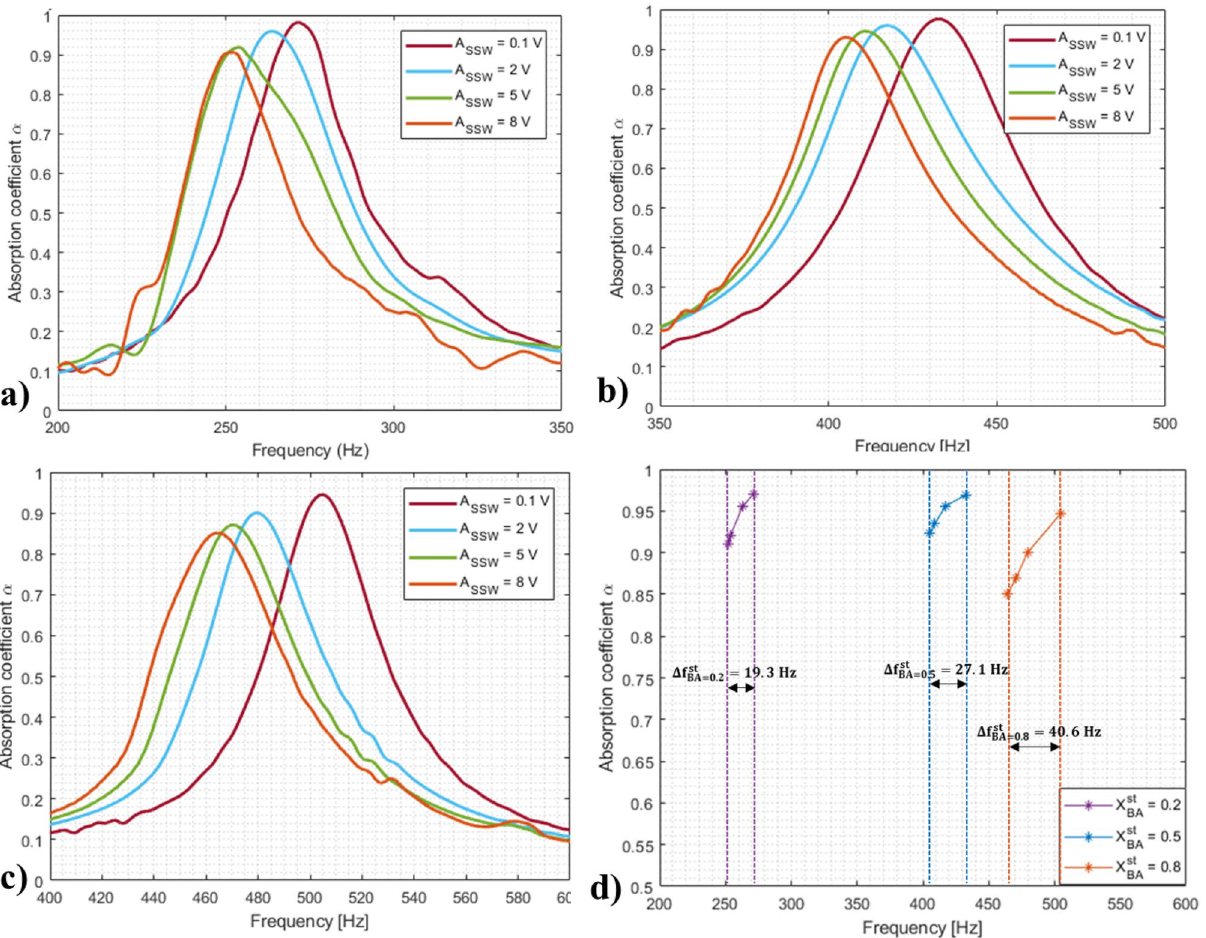
st = 0.2; ( b ) X st = 0.5; ( c ) BA BA